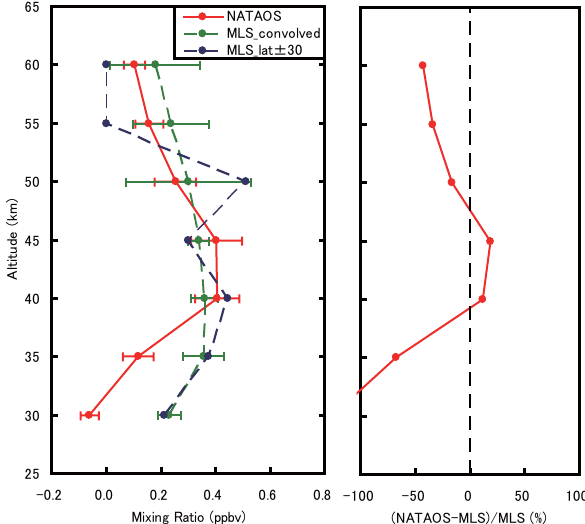
Fig. 7. (Left) Comparison of the vertical ClO profiles measured by NATAOS radiometer and AURA/MLS averaged for correspond- ing location (longitude: ± 30 ◦ and latitude ± 2 ◦ from Atacama) and time (12:00–15:00LT at the position of the AURA satellite between 5 and 16 December 2009). For the MLS profiles, blue and green dashed lines correspond to unconvolved and convolved profiles by the NATAOS averaging kernel, respectively. (Right) Percentage dif- ference between NATAOS radiometer and convolved MLS profiles.